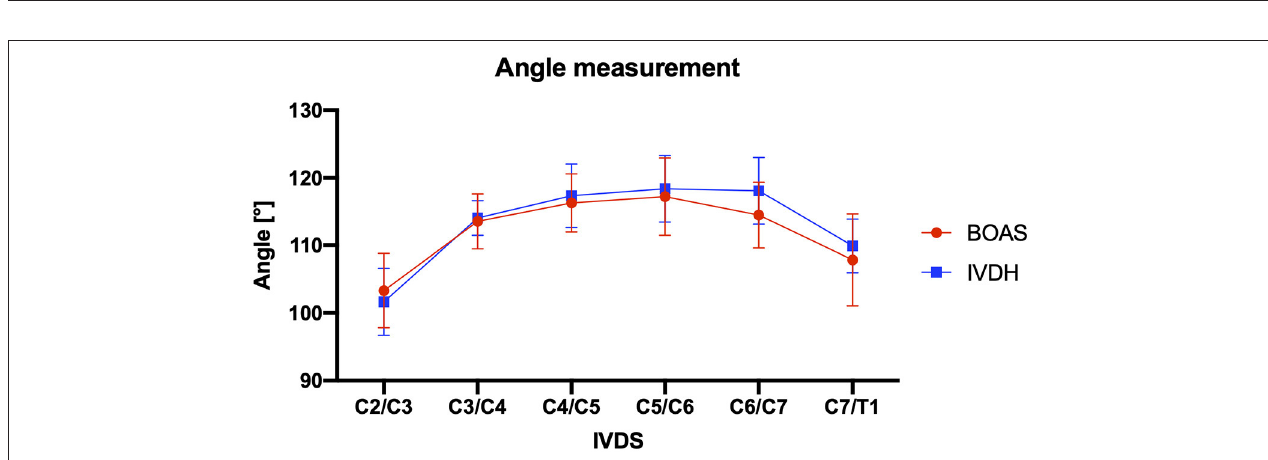
FIGURE 7 | Line graph showing mean angles of intervertebral disk to vertebral body at each IVDS of the cervical spine from C2/C3 to C7/T1 in French bulldogs of the BOAS group (red line) and the IVDH group (blue line).